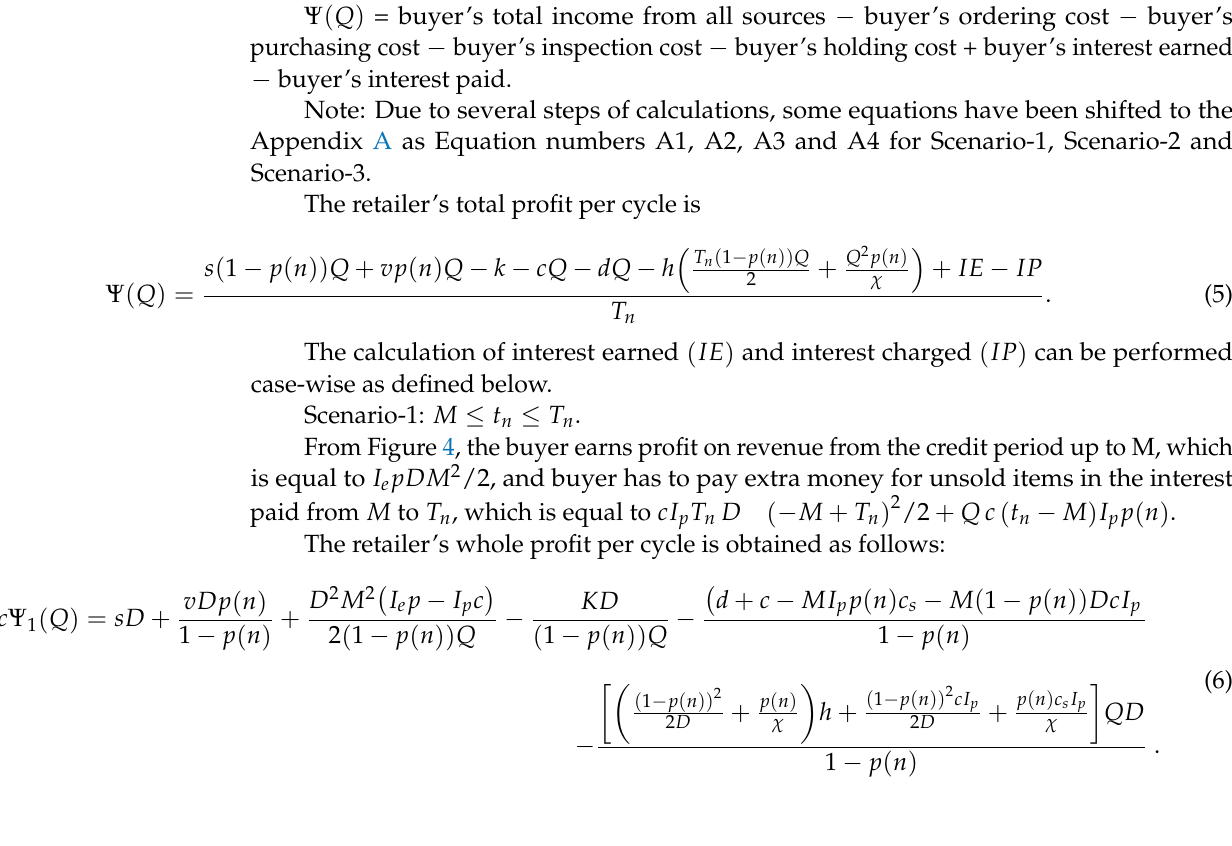
Figure 3. Inventory with time under trade credit